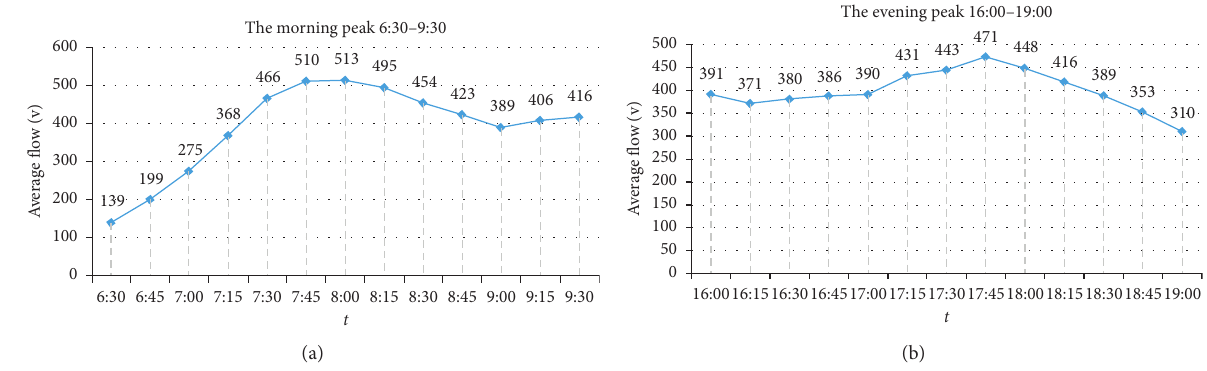
Figure 10: Morning and evening peak traffic flow of Balong road intersection.